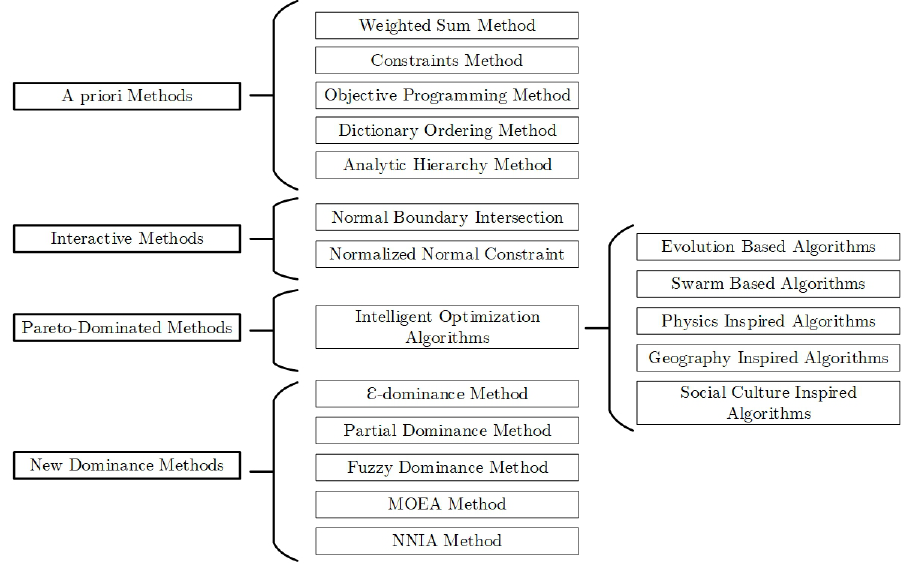
Figure 5. Multi-objective trade-off optimization methods